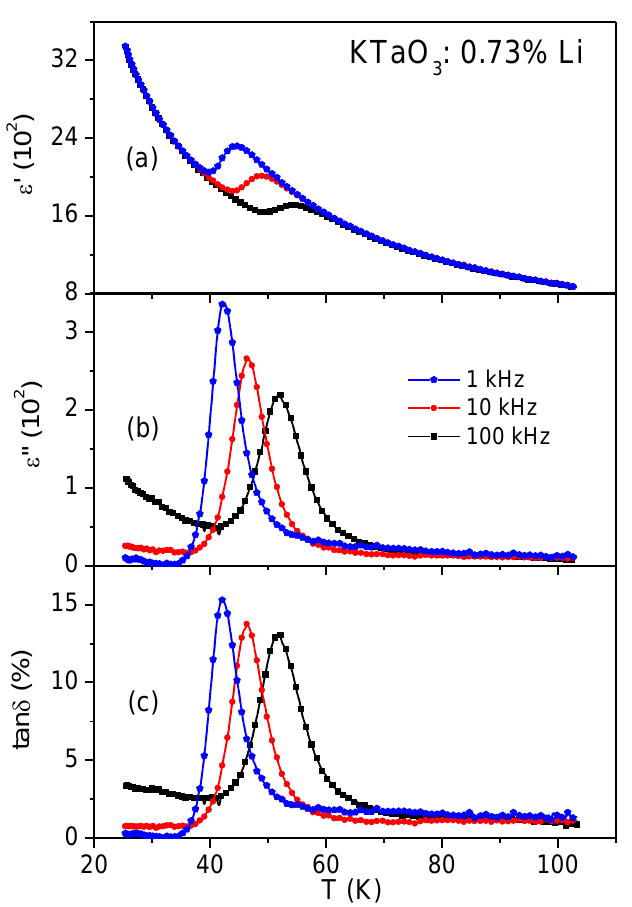
Figure A1. Real ε ’ ( a ) and imaginary ε ’’ ( b ) parts of the dielectric permittivity and dissipation factor tan δ ( c ) of KTaO 3 : 0.73% Li single crystals as a function of temperature T at 1 (pentagon), 10 (circle) and 100 (square) kHz.